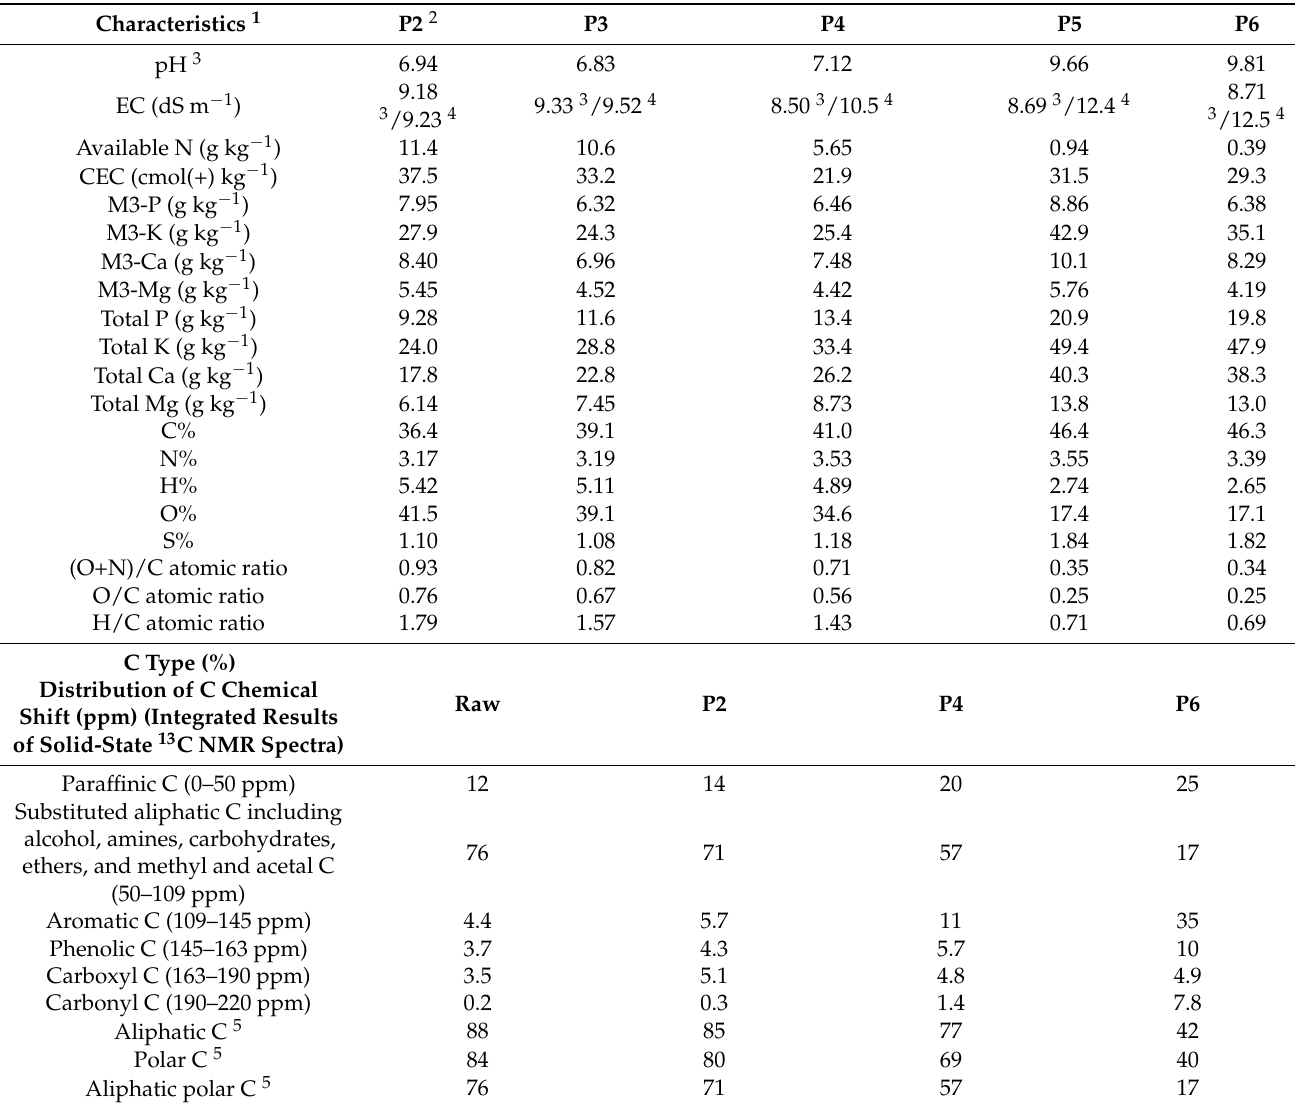
Table 1. Characteristics of the five studied